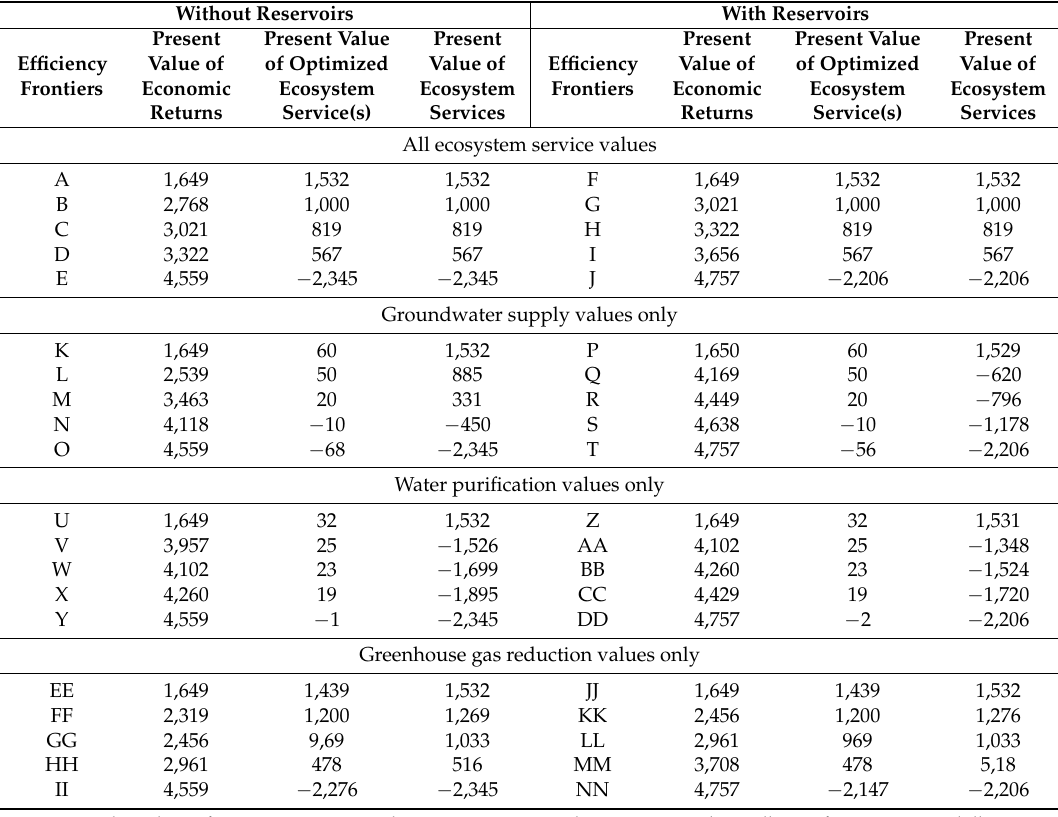
Table 1. Ecosystem service and economic return values for points along efficiency frontiers. Without Reservoirs With Reservoirs Present Present Present Value Present Value Present Present Value of Value of Value of of Optimized Value of of Optimized Efficiency Efficiency Ecosystem Ecosystem Ecosystem Ecosystem Economic Economic Frontiers Frontiers Services Services Service(s) Service(s) Returns Returns All ecosystem service values